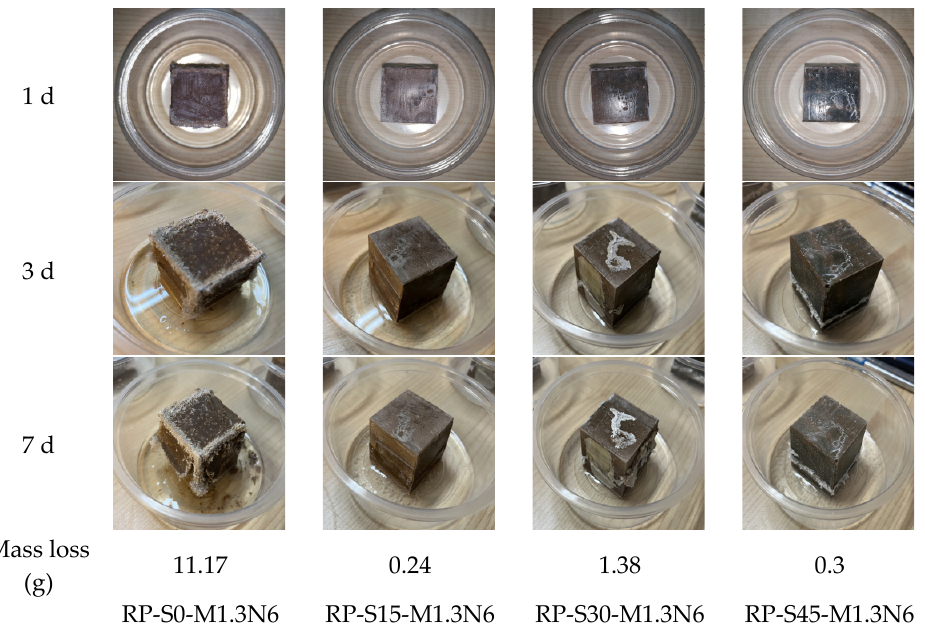
Figure 11. Visual efflorescence of RPSG with different slag contents.